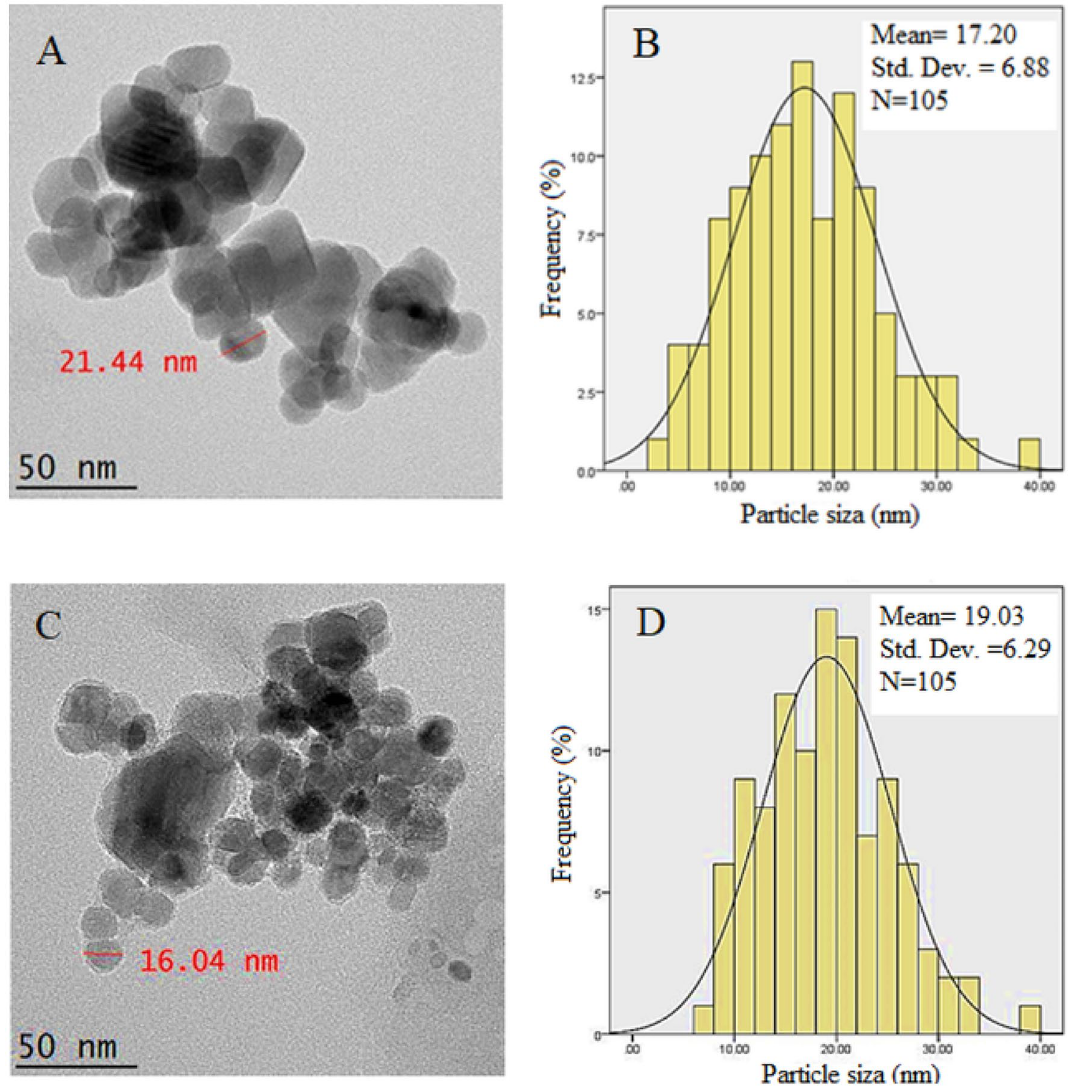
Figure 8. Transmission electron micrographs for ( A ) core–shell nanoparticle (FPEGSO-MLDH) (50 nm bar); ( C ) core–shell nanoparticle (FPVASO-MLDH) (50 nm bar); ( B , D ) their particle size